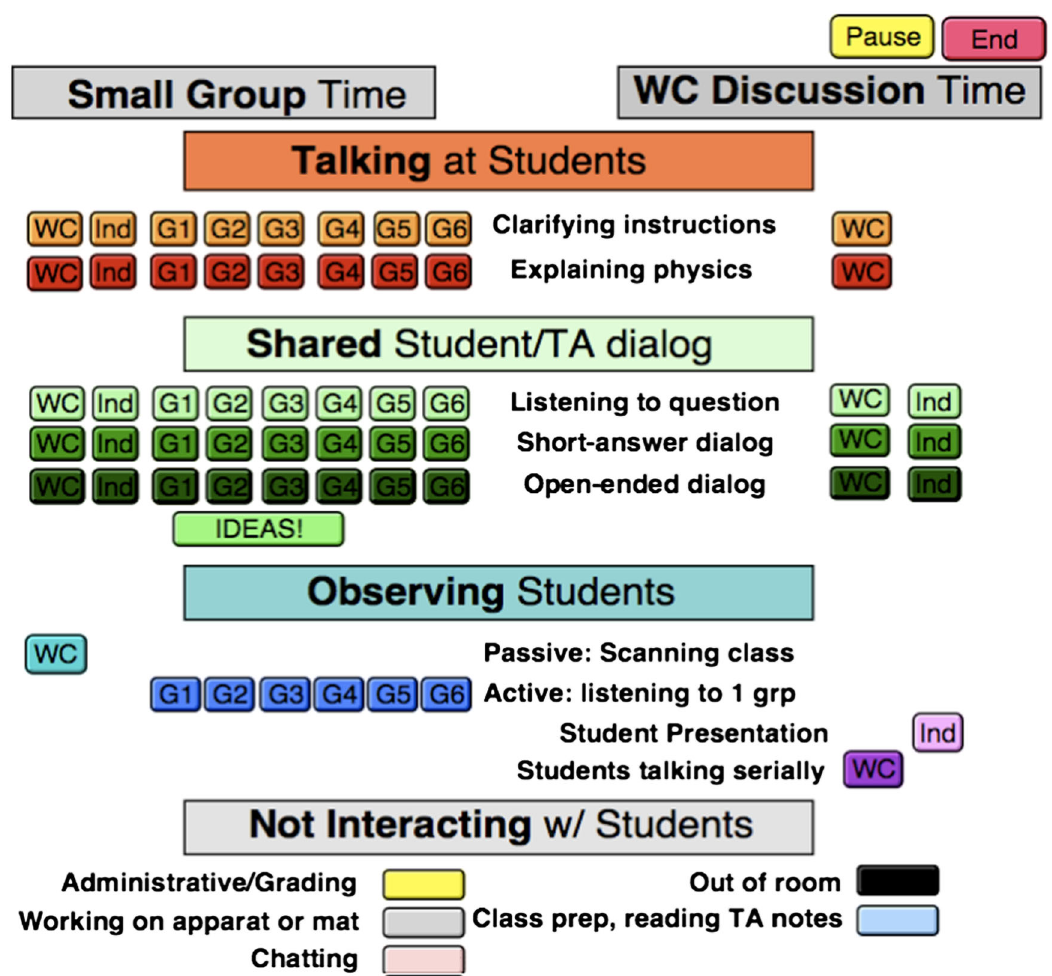
FIG. 6 (color online). Screen shot of the real-time instructor observing tool ( RIOT ). The left side of the screen is for when the class is in small group mode, and the right side is for when the class is in whole class mode. The screen is divided horizontally into four larger categories: Talking at Students, Talking with Students, Observing Students, and Not Interacting with Students. Under each of these larger categories are more precise categories. Each row of icons corresponds to the smaller category name that is written next to it. Each small icon labeled WC, Ind, and G1–G6 represents who the instructor is interacting with (whole class, an individual, and groups 1-6,